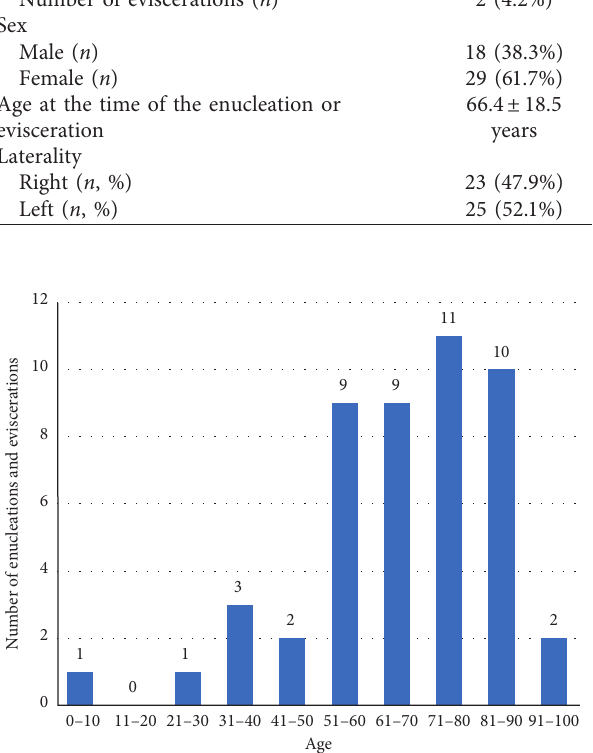
Figure 1: Age distribution (at the time of surgery) of patients who underwent enucleation or evisceration due to infectious keratitis between January 2007 and December 2018 at the Department of Ophthalmology of Semmelweis University (Budapest, Hungary) (48 eyes of 47